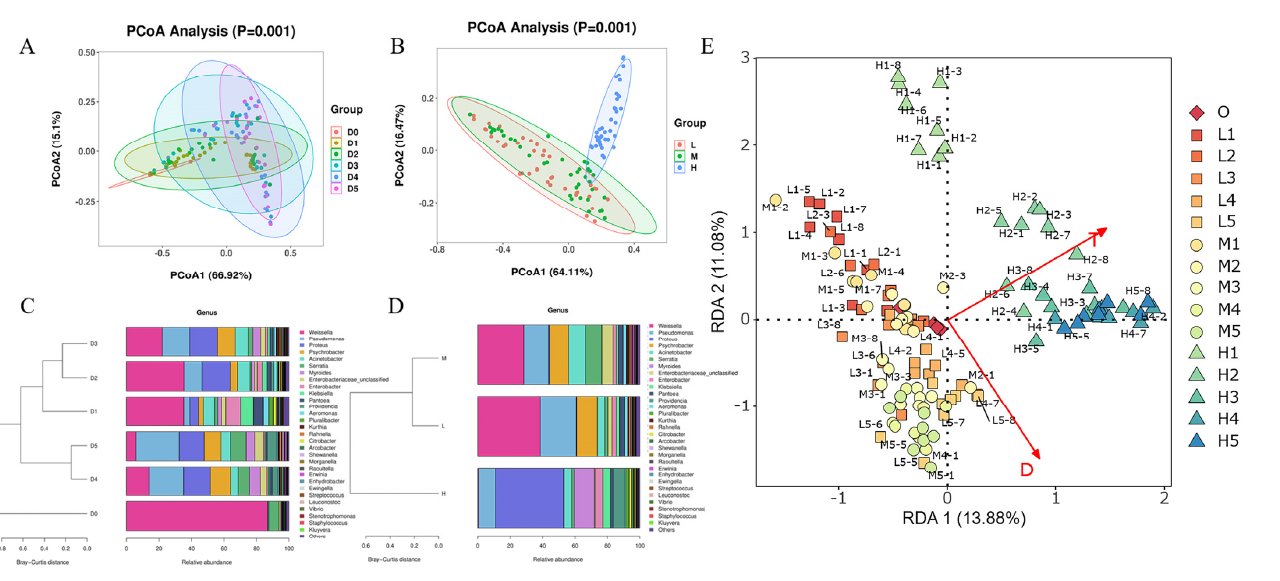
Figure 2. Relative abundance (%) of bacterial taxa based on 16S rDNA sequencing. ( A ) Phylum, ( B ) genus and ( C ) species levels in the RTE chicken meat samples during storage. The mul- ti-colored stack bar graphs display the relative abundances of bacteria in each sample.